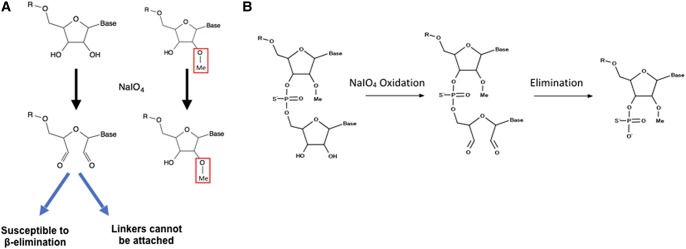
(A) Oxidation of RNA 3′-ends by sodium periodate (NaIO4). RNA fragments that are terminally methylated are protected from oxidation, while nonmethylated fragments will have their ends oxidized into dialdehyde, thus losing reactivity to ligation reactions. (B) To expose 2′-O-methylated bases at the 3′-terminus, at least one round of β-elimination is required. RNA fragments are first oxidized, then β-elimination catalyzes the leaving of 3′-terminal bases.